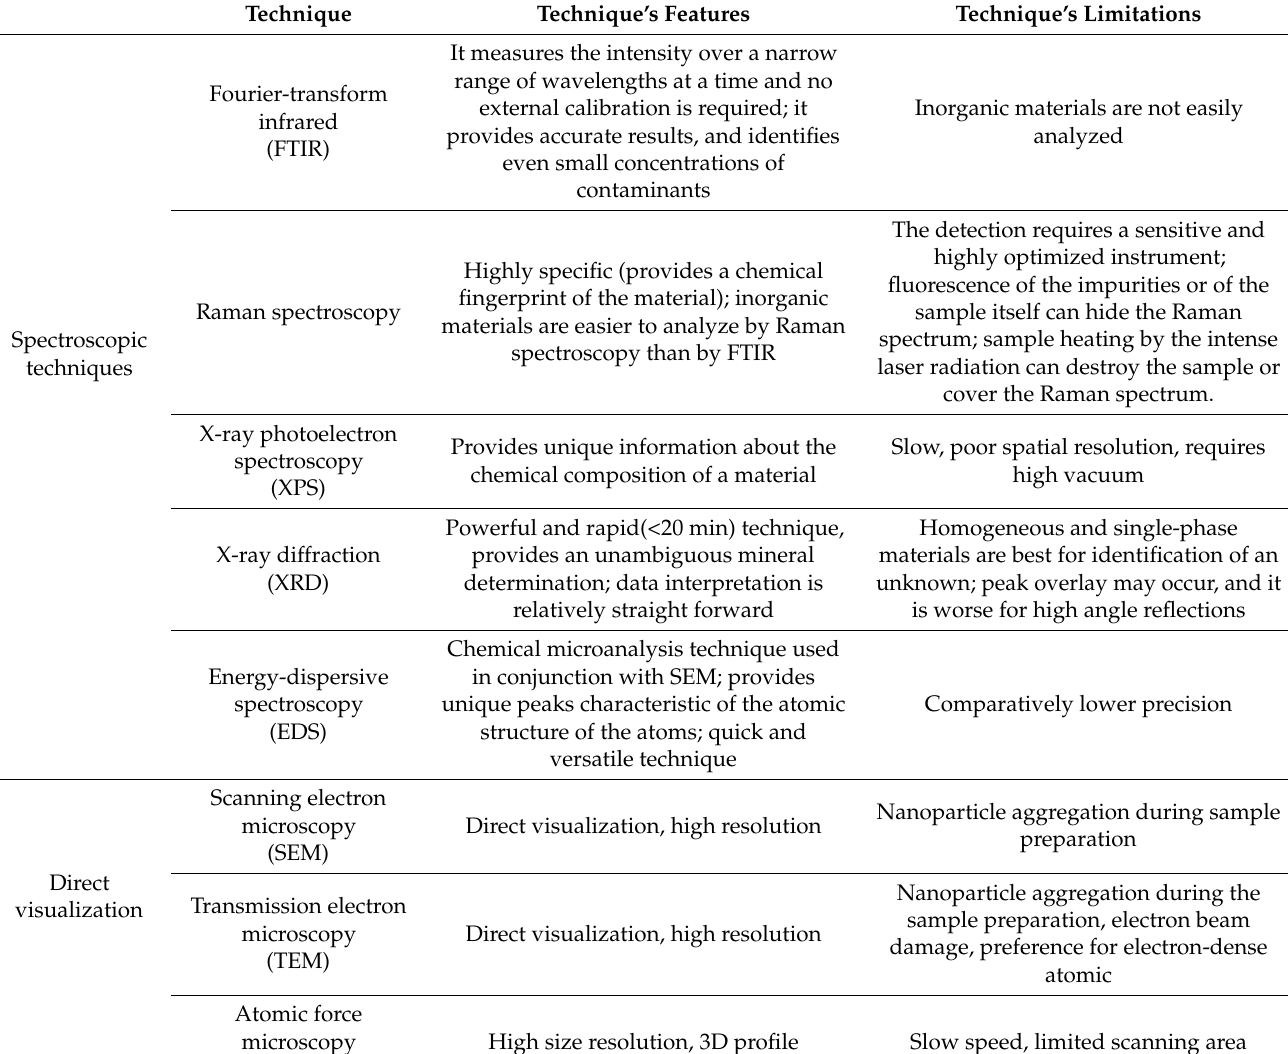
Table 1. Classification, features, and limitations of the techniques used for HA characterization. Adapted from [47] under the terms of the Creative Commons CC BY license, accessed on 30 May